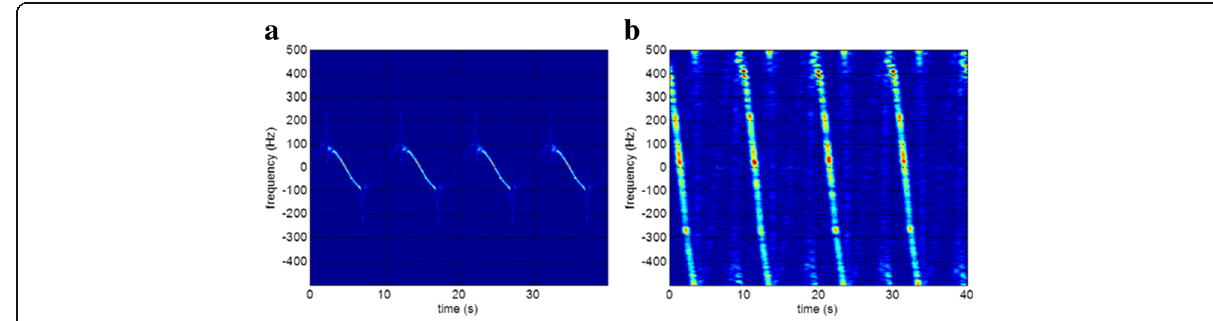
Fig. 14 Time-frequency distributions of the cone-top. a The non-aliasing situation. b The aliasing situation